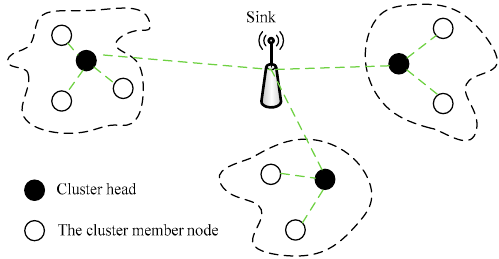
Figure 2. The system model of LEACH [51].